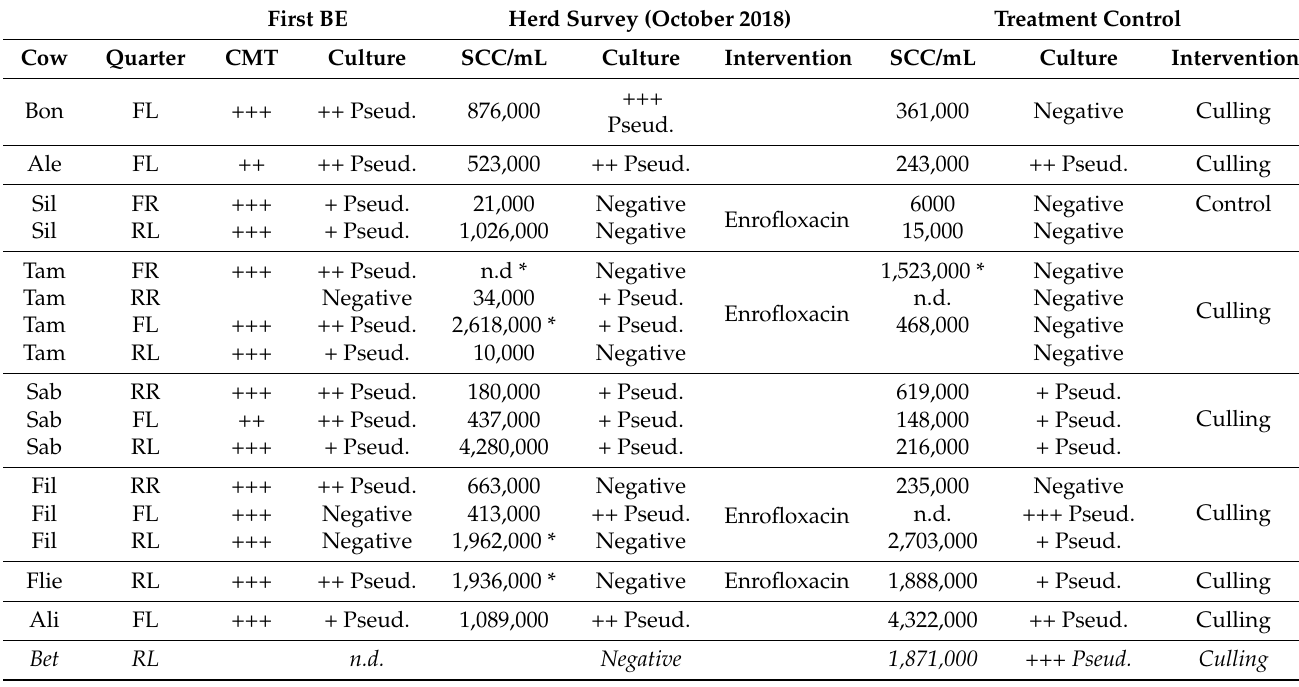
Table 3. Results of bacteriological examination (BE), MSCC measurement and interventions of all cows infected with P. aeruginosa (Pseud.) .